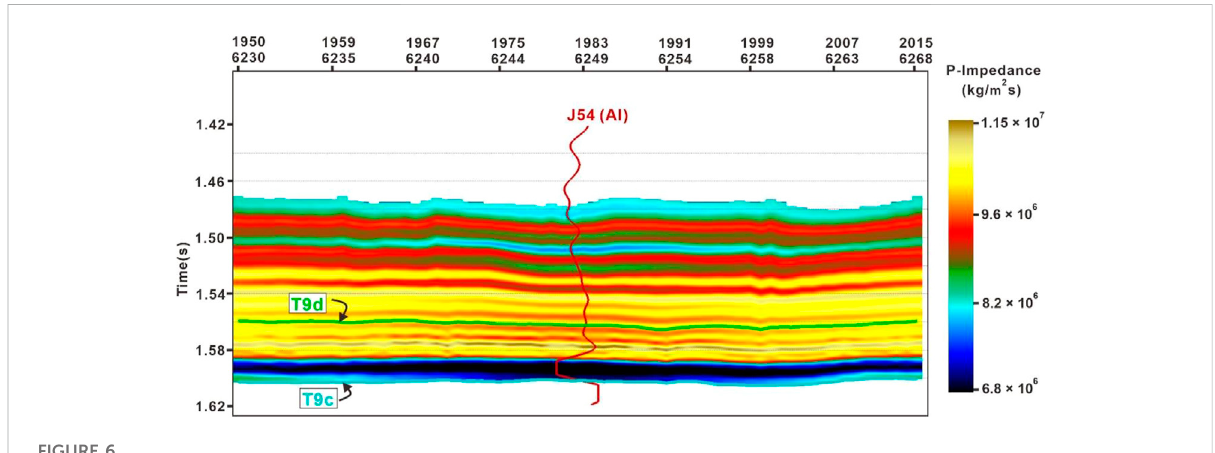
FIGURE 6 Low-frequency model created for study